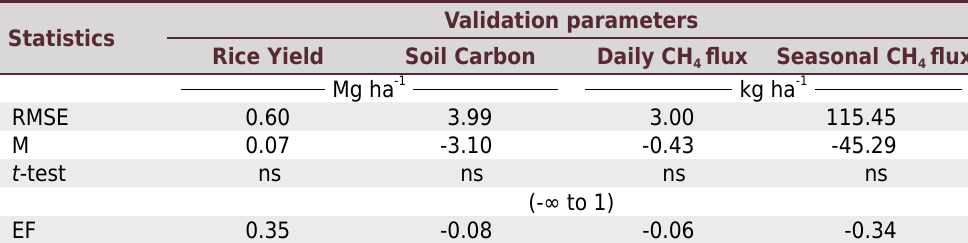
Table 3. Statistical analysis of simulated and observed parameters under no-tillage treatment (model validation) in a long-term experiment at the Rice Research Station in southern